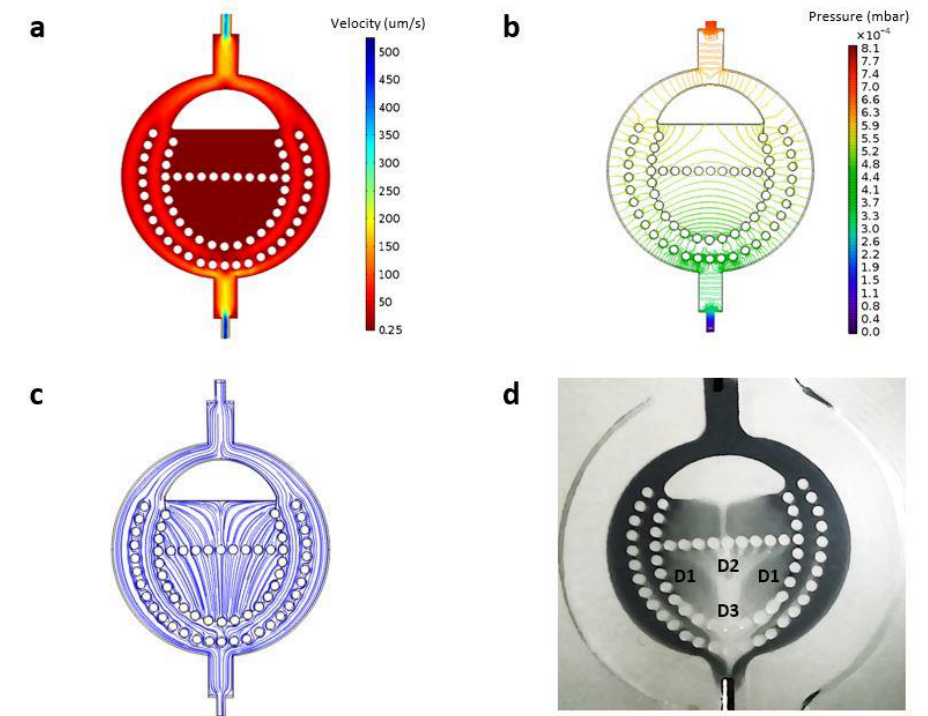
Figure 3. Flow within the LN-on-a-chip. ( a ) Magnitude of velocity field in the LN-on-a-chip. The highest velocities were at the inlet and the outlet. The lowest velocity was in the central area (regions 3A and 3B) with an average value of 0.25 µ m / s. ( b ) Pressure distribution in the LN-on-a-chip ( c ) Streamlines showing direction of the flow within the LN-on-a-chip. ( d ) Flow of a colored water solution within the LN-on-a-chip. The flow gave rise to 3 functionally di ff erent districts within region 3B labelled D1, D2, and D3.